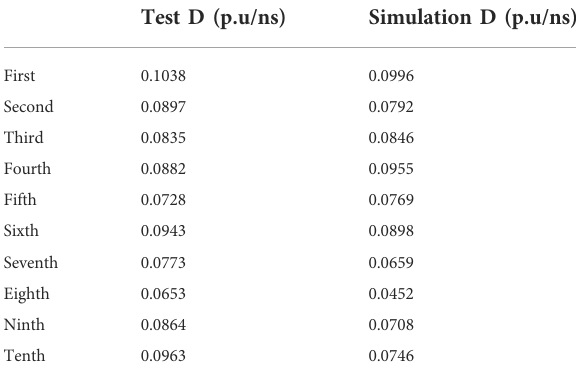
TABLE 2 Statistics of wave head steepness of the last 10 single arcing waveforms of VFT during opening. Test D